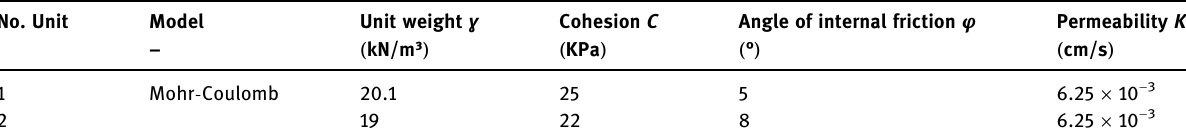
Table 2: Earth canal material properties before rationing system No.